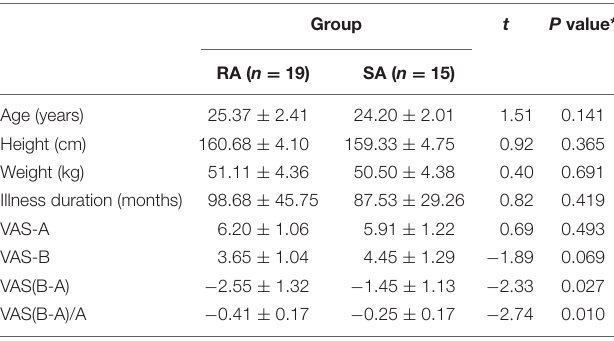
TABLE 1 | Baseline patient characteristics and average pain intensity before and after acupuncture treatment. Group